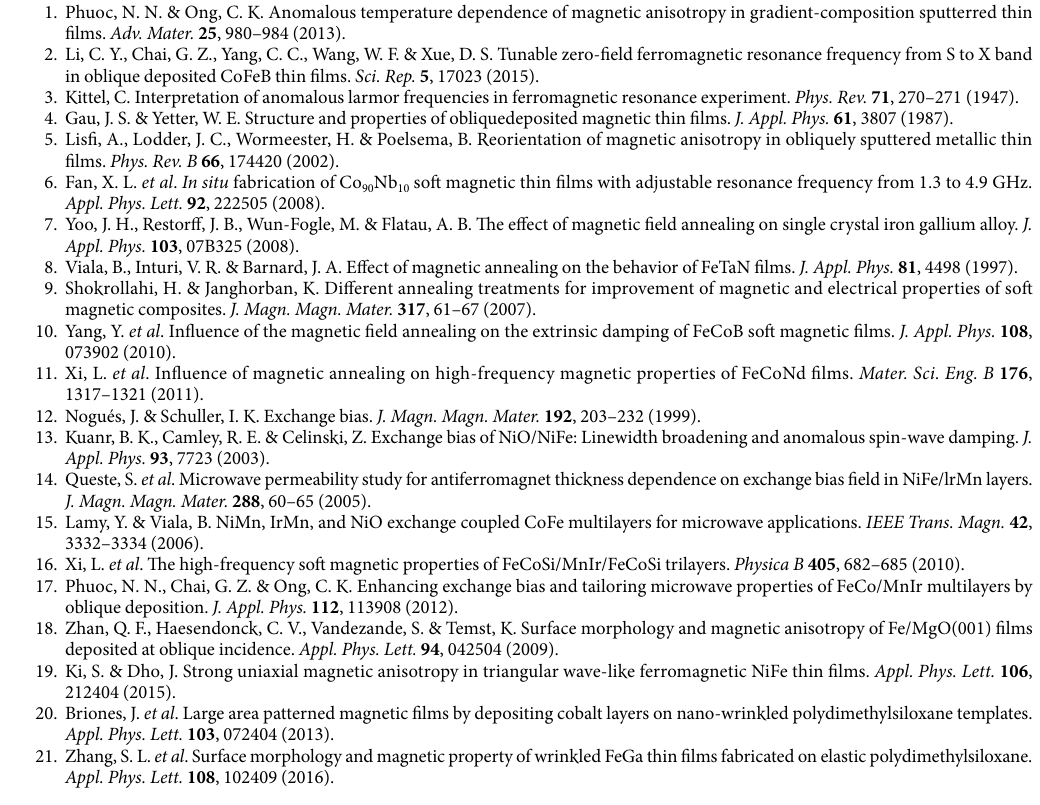
FeCoTa layers were controlled by the deposition time and were calibrated by X-ray reflectivity. The surface mor- phology was characterized by an atomic force microscope (AFM, Veeco Dimension 3100V). The hysteresis loops were measured by using a vibrating sample magnetometer (VSM, Lakeshore 7410). The permeability spectra were obtained at zero bias field by using a vector network analyzer (Agilent E8363B) with a shorted microstrip transmission-line perturbation method. All the measurements were conducted at room temperature.